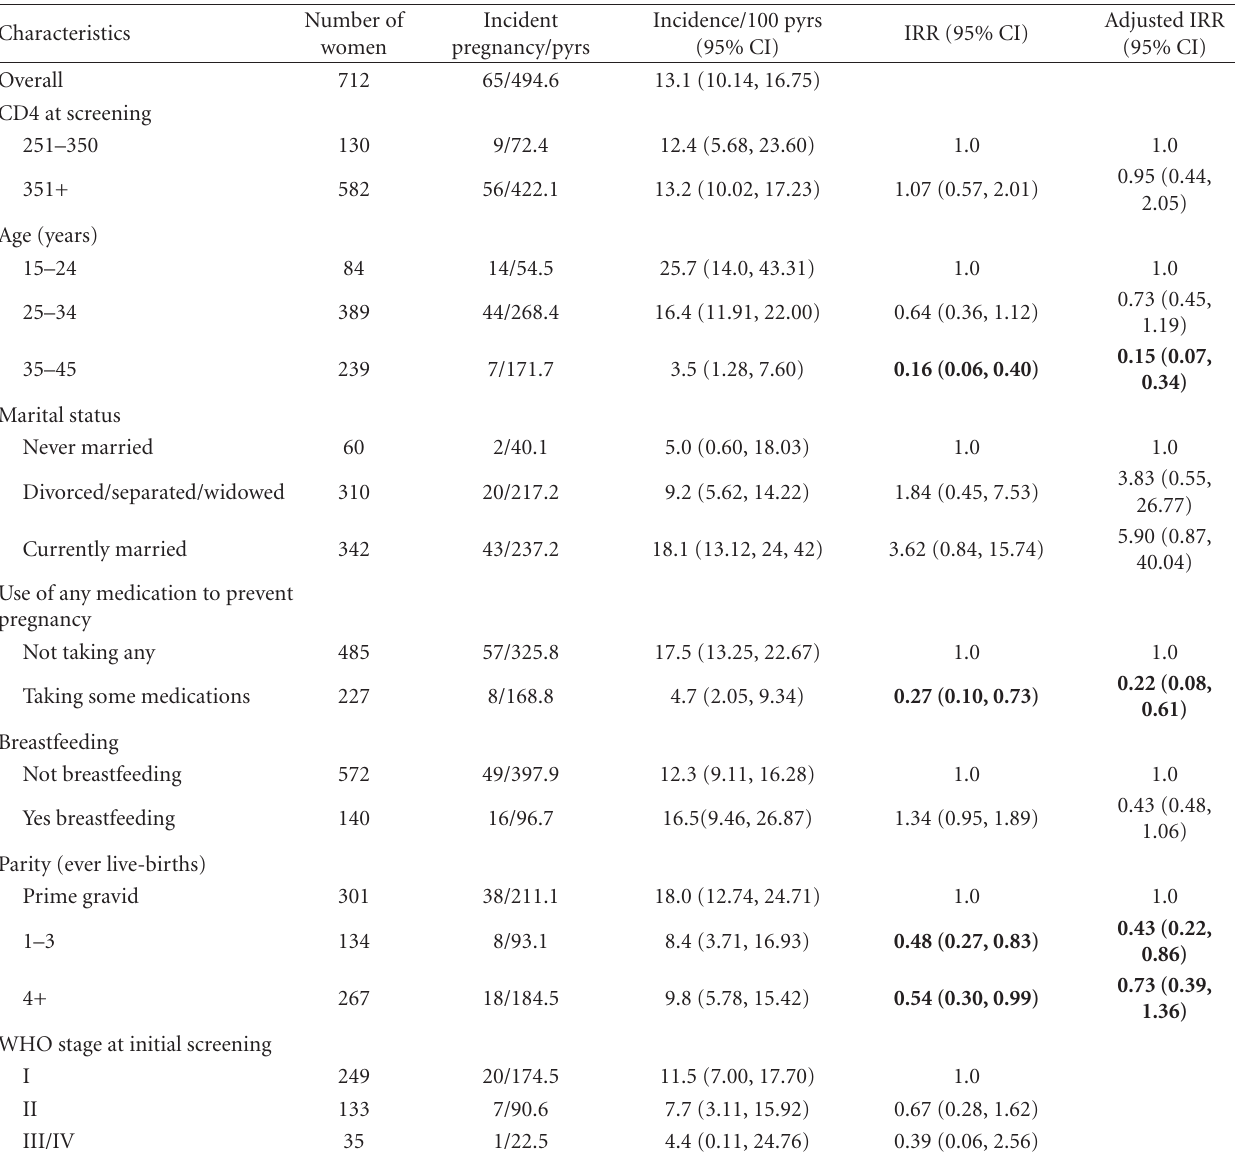
Table 3: Incidence of pregnancy, unadjusted and adjusted incidence rate ratios among HIV+ women prior to ART initiation.